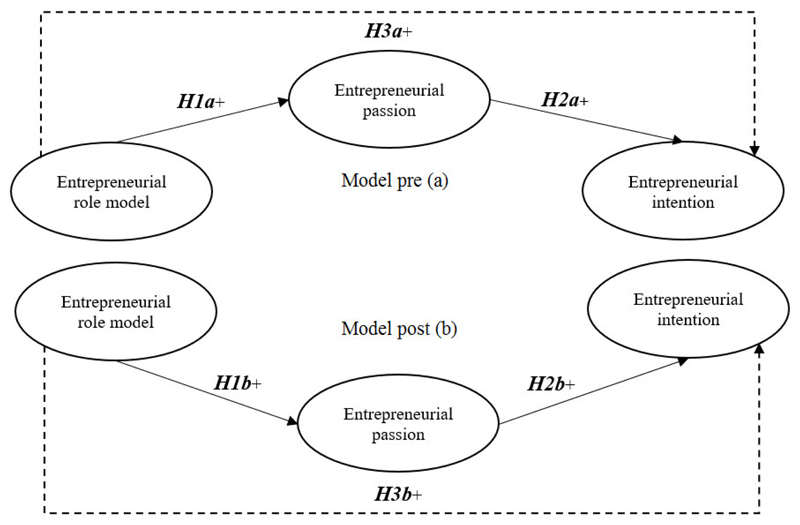
Proposed Research Model